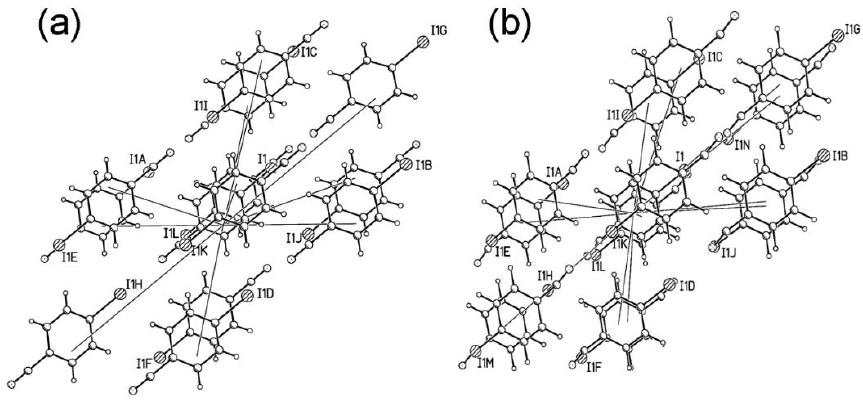
Figure 4. First coordination spheres of ( a ) Phase I at 5.0 GPa. Notice the ABC layering sequence in the vertical direction. ( b ) Phase II at 5.5 GPa.